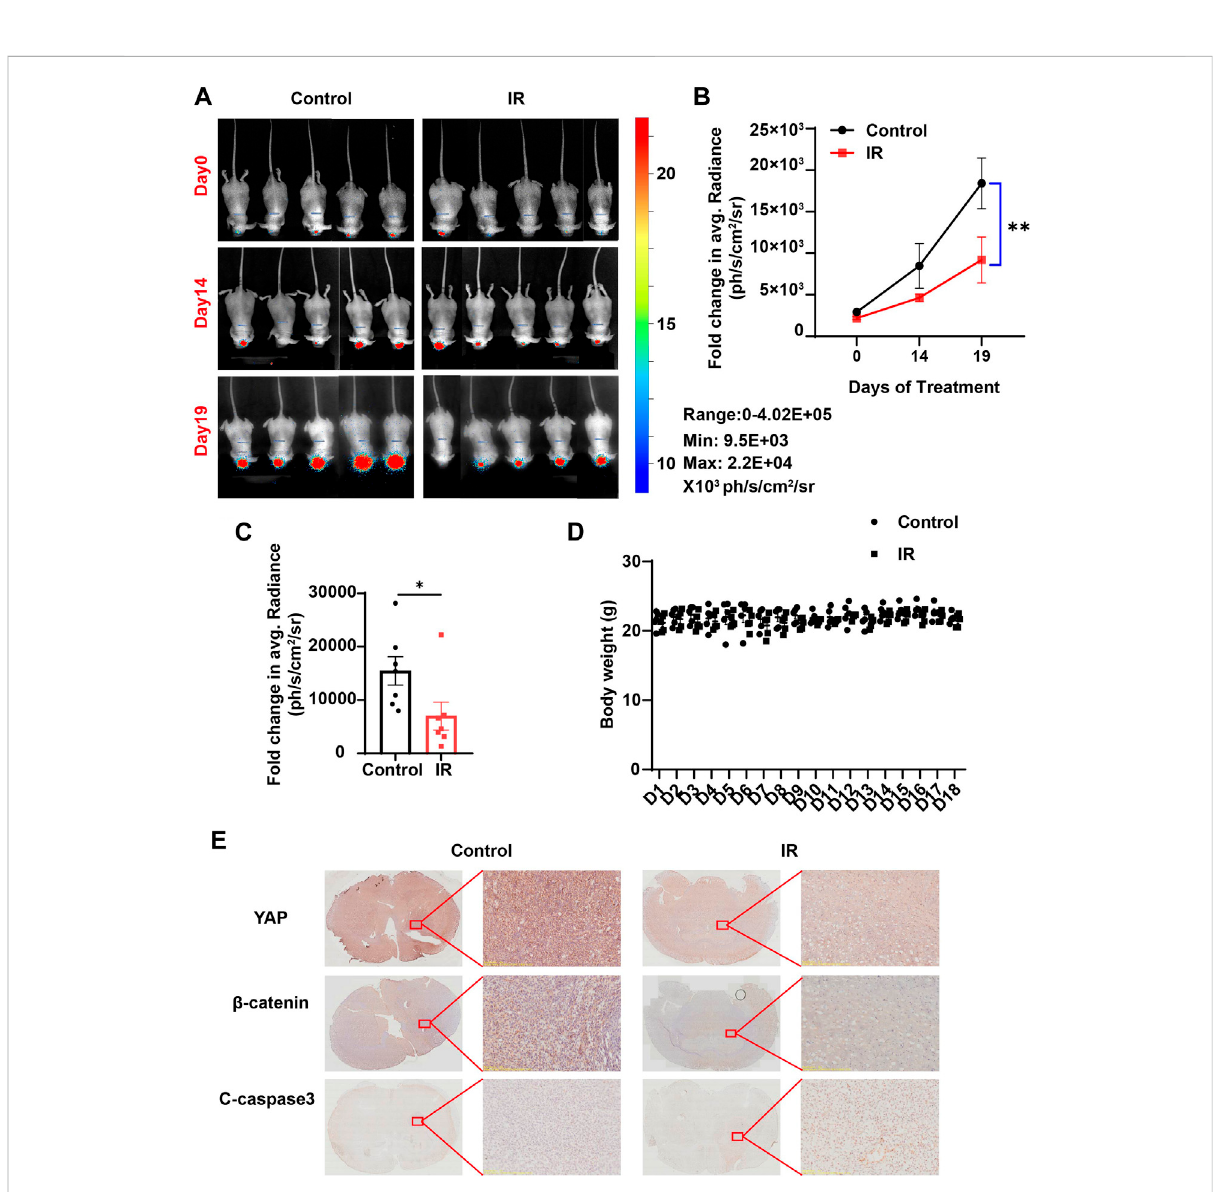
FIGURE 8 IrigenininhibitedtumorigenesisofGBM invivo . (A) BioluminescentimagingofdisseminatedC6-Lucorthotopicxenograftmiceatdifferenttime pointsposttreatmentwithIRandthecontrolgroup. (B) Foldchangeintheaverageradiancepermouseafternormalizationtotheday0tumorburden as determined by bioluminescent imaging ( n = 7 mice, per group). (C) Fold change in the average radiance per mouse at the experimental endpoint (day19)foreachtreatmentgroup(n=7mice,pergroup). (D) Thebodyweightofthetumor-bearingmicewasmonitoredeveryday(n=5mice, per group). (E) DAB staining of YAP, β -catenin and cleaved-Caspase 3 in GBM tumor of xenograft mice. Data were shown as mean ± SEM. *p < 0.05 , ** p < 0.01, compared with control treatment.